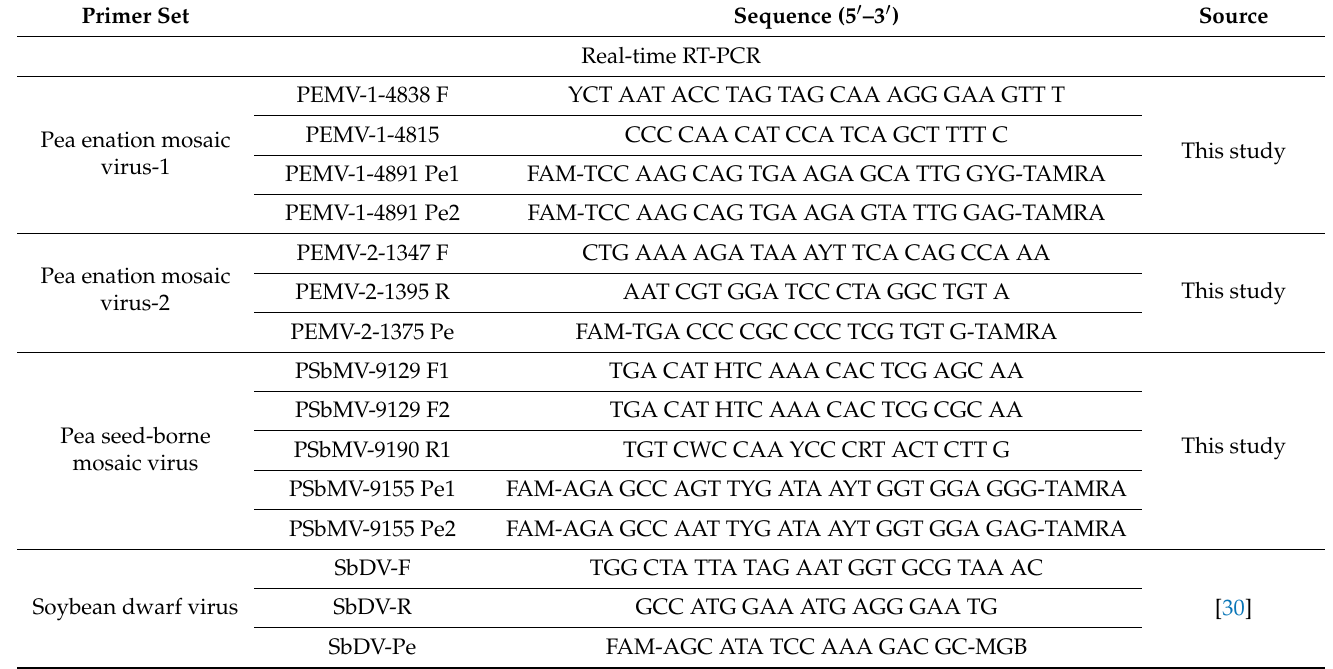
Table 1. Real-time RT-PCR and RT-PCR assays used within this work. Sequence (5 (cid:48) –3 (cid:48)